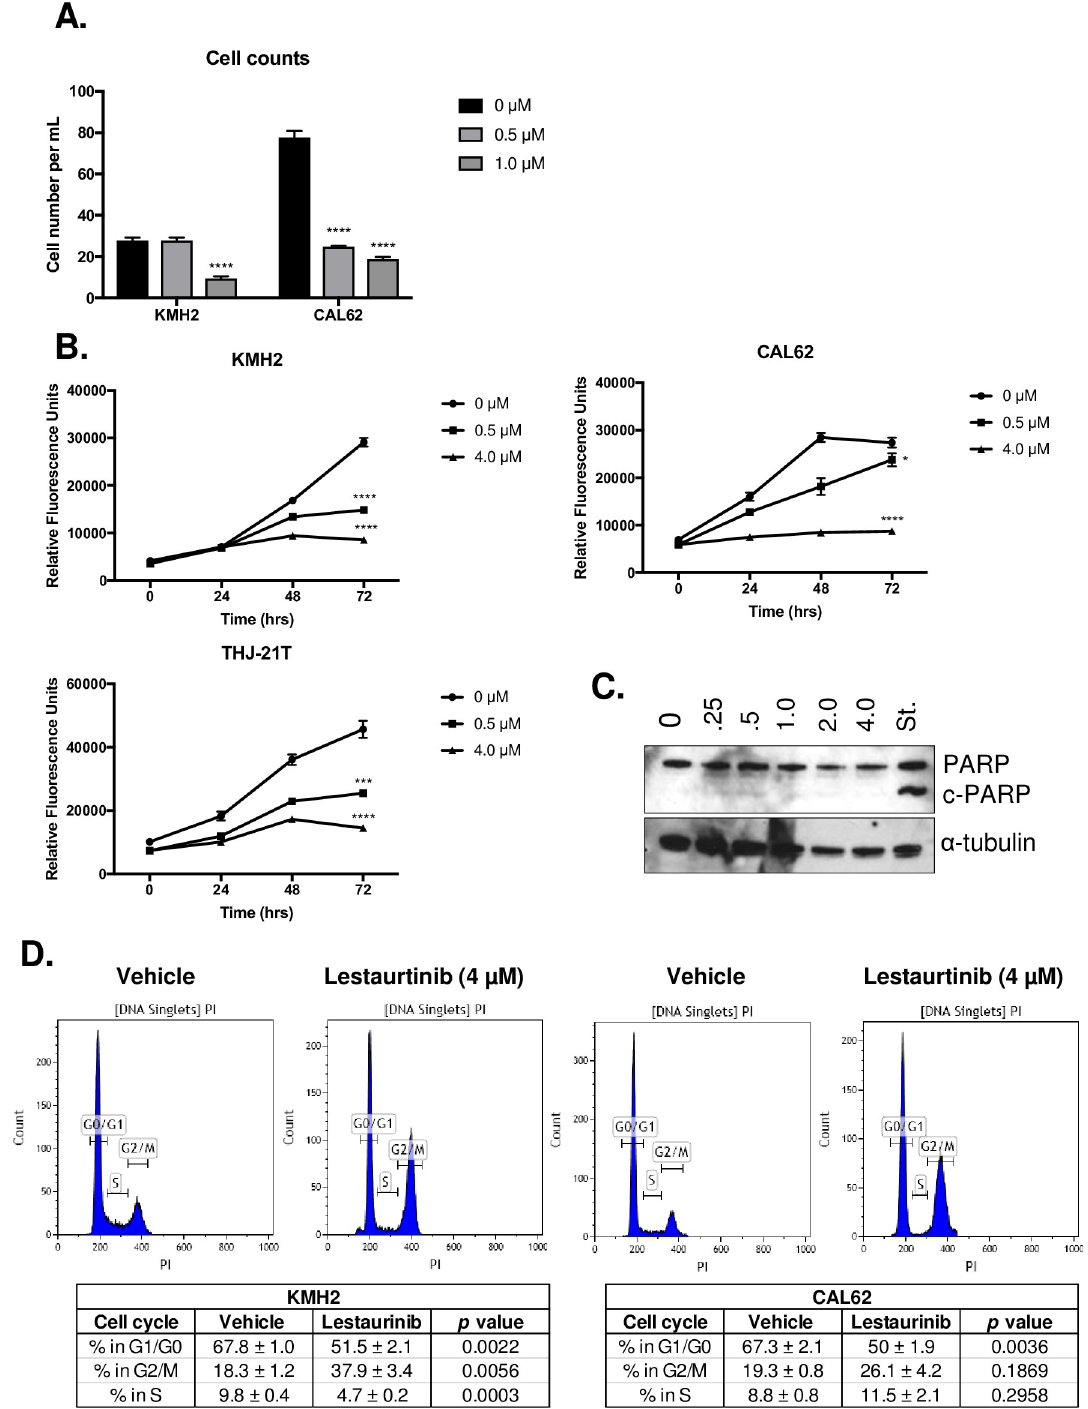
Fig 4. Lestaurtinib exhibited a cytostatic effect on ATC cells, in vitro . (A) Effect of Lestaurtinib (0.5 μ M and 1.0 μ M) on cell number following 24 h of treatment (3 replicates per line) for KMH2 and CAL62 cell lines. (B) Growth curves for KMH2, CAL62 and THJ-21T cell lines following treatment with Lestaurtinib at 0, 24, 48 and 72 h, with 3 technical replicates per timepoint. Statistical analysis is shown for the 72 h timepoint when compared to the untreated control for the same timepoint. (C) Western blot showing expression of cleaved PARP (c-PARP) following 24 h of Lestaurtinib doses (0.25–4.0 μ M) relative to the apoptosis-inducing Staurosporine (St.) control. (D) CAL2 and KMH2 cells were treated with Lestaurtinib (4.0 μ M) for 24 h (3 replicates per line) prior to BrdU incorporation and labeling of cells with propidium iodide. A minimum of 10,000 events were counted per test. Proportions of cells within each